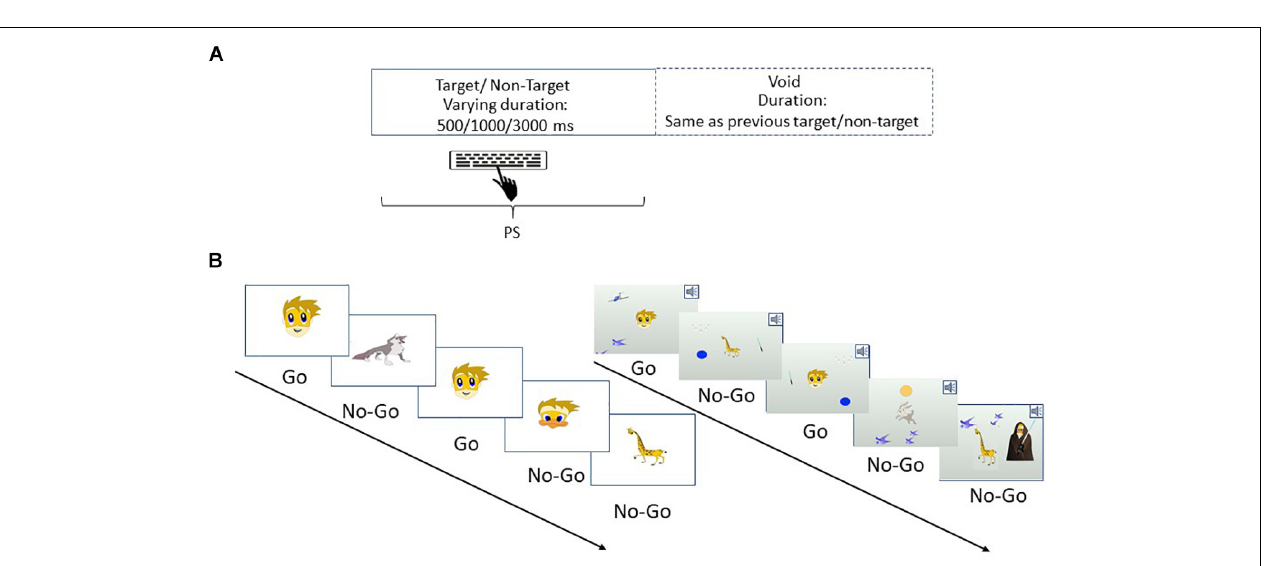
FIGURE 1 | Study design. (A) Participants were randomized into two groups, each receiving treatment in weeks 1 and 3, with a gap period of no-treatment in weeks 2 and 4. Group 1 received tDCS + CT (black rectangles) in week 1 and transcranial random noise stimulation (tRNS) + CT (white rectangles) in week 3, while group 2 received the opposite pattern. PS was assessed at five time points during the study: baseline (t0) immediately post-treatment (t1, N-t1), and at follow-up, after a week of no treatment (t2, N-t2). (B) An example of tES + CT sessions. Children were seated in front of the tablet which delivered the CT, while being stimulated for 20 min each session. Pictures of children are included with written permission from participants and their parents.